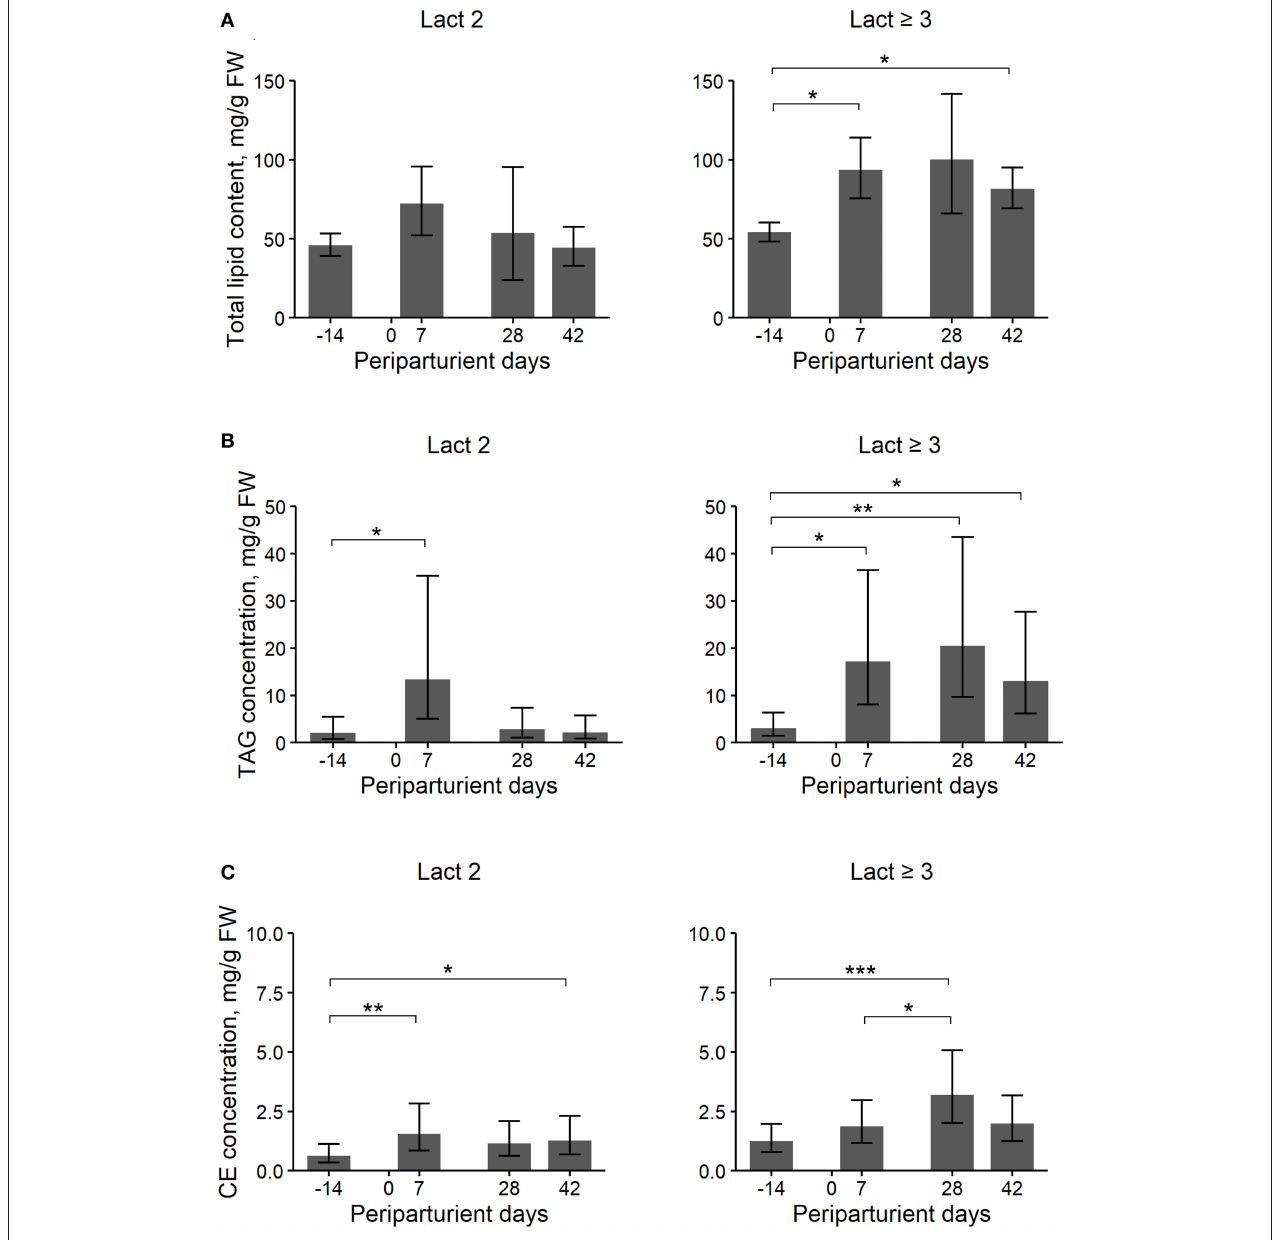
FIGURE 1 | Least Square Means (LSM) and their 95% confidence intervals (error bars) for the hepatic total lipid (TL) (A) , triacylglycerol (TAG) (B) , and cholesterol ester (CE) (C) content (mg/g liver fresh weight, FW) at four periparturient sampling days [ − 14 = d 14 antepartum (a.p.); 0 = parturition; 7, 28, 42 = d 7, d 28, d 42 postpartum (p.p.)] for two groups (Lact2 = lactation 2, n = 3 and Lact ≥ 3 = lactation 3 or greater, n = 5) of German Holstein cows. Significances between sampling days within groups ( P -values F-test): TL: Lact2: P = 0.24 , Lact ≥ 3: P = 0.03 ; TAG: Lact2: P = 0.03 , Lact ≥ 3: P < 0.01 ; CE: Lact2: P < 0.01 , Lact ≥ 3: P < 0.01 . Significant differences between days within group are marked with asterisks (* P < 0.05 ; ** P < 0.01 ; *** P < 0.001